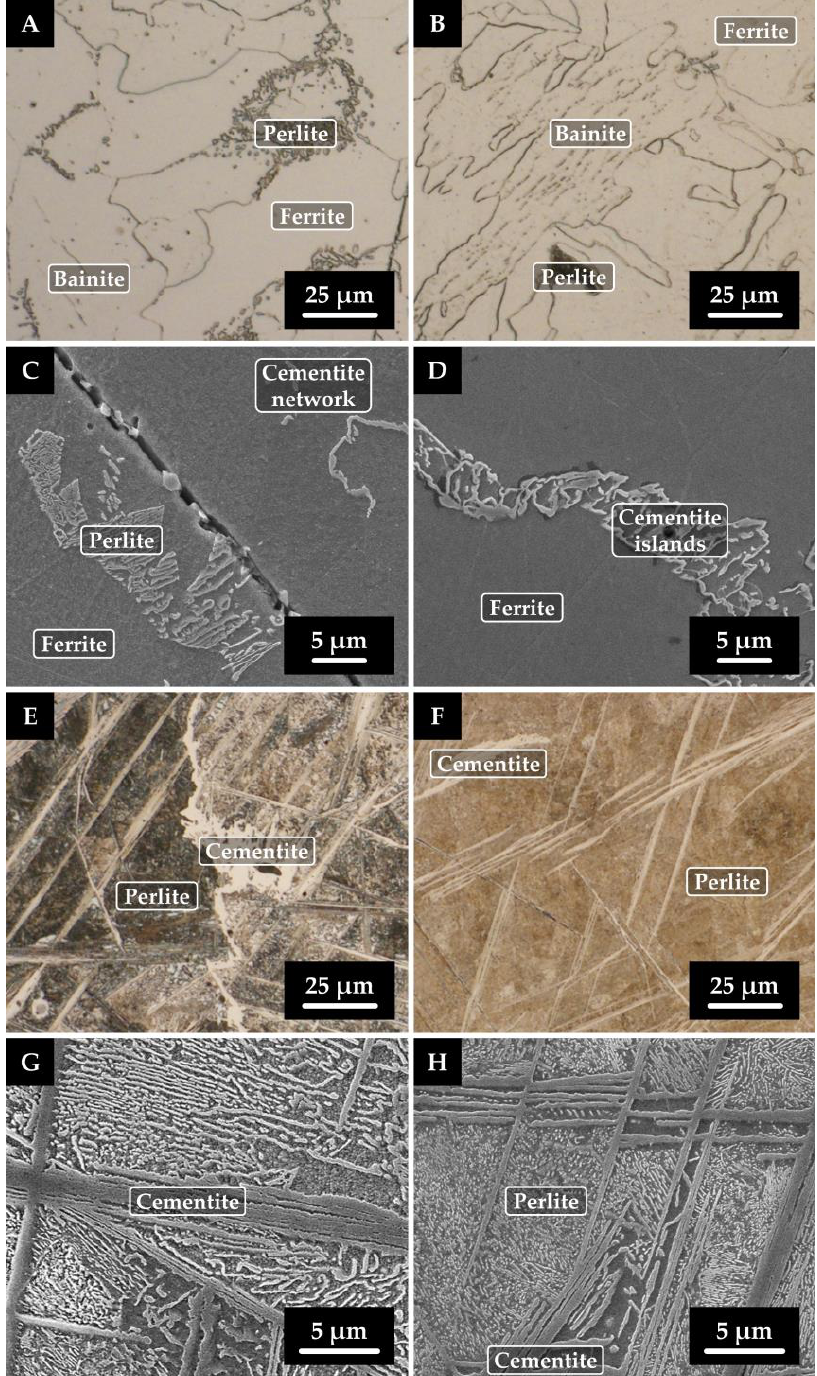
Figure 4. Microstructure of nickel sample 5 ( A – D ) with lower carbon content and sample 6 ( E – H ) with higher carbon content; left column—initial state, right column—remelted state; ( A , B , E , F )—light microscopy, ( C , D , G , H )–scanning electron microscopy.